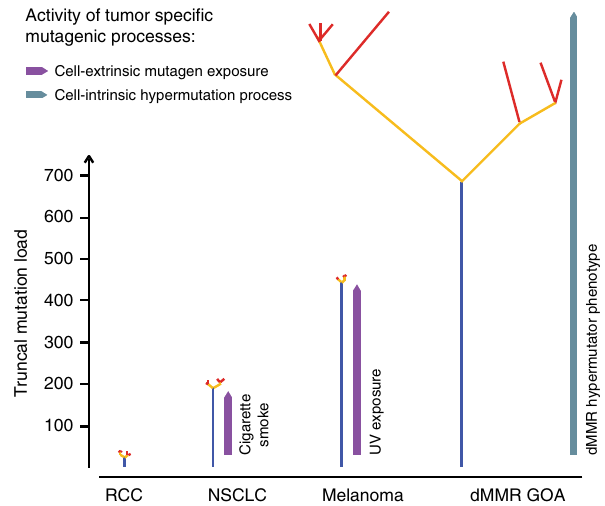
Fig. 7 Comparison of phylogenetic tree morphologies across four cancer types analysed by MSeq. Schematics of branched phylogenetic trees drawn with similar branching structures to those directly observed in each of the four tumour types 11,16,19 . Trees were scaled so that trunk and branch lengths are proportional to the average number of ubiquitous and heterogeneous non-silent mutation loads of each tumour type (Fig. 1c). Phylogenetic tree colour code: blue: truncal mutations, yellow: shared mutations, red: private